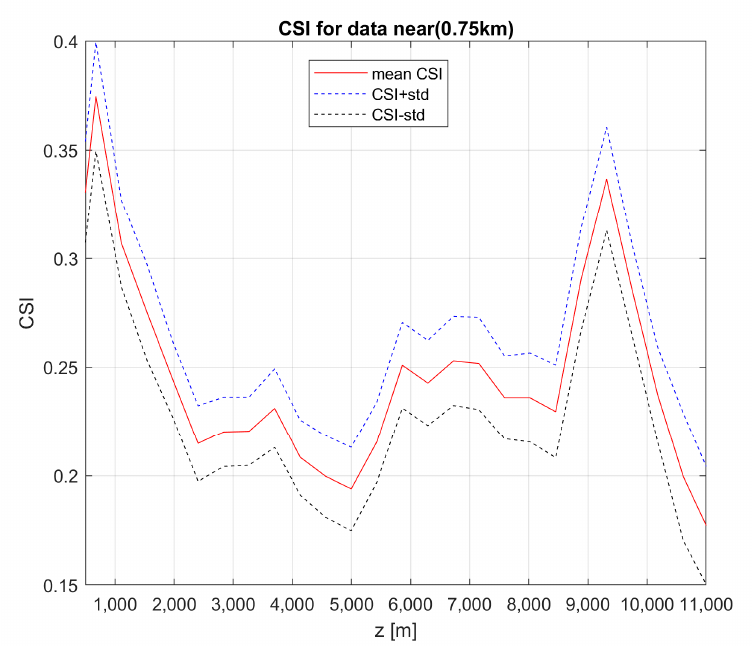
Figure 15. Calculated Critical Success Index (CSI) in dependence on elevation above the radar site (z [m]). The figure shows mean values of CSI (red solid line) and mean CSI ± standard deviation of CSI (dashed lines).